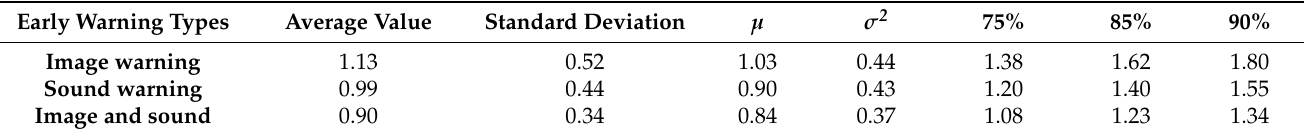
Table 3. Driver reaction time in accidents (unit: